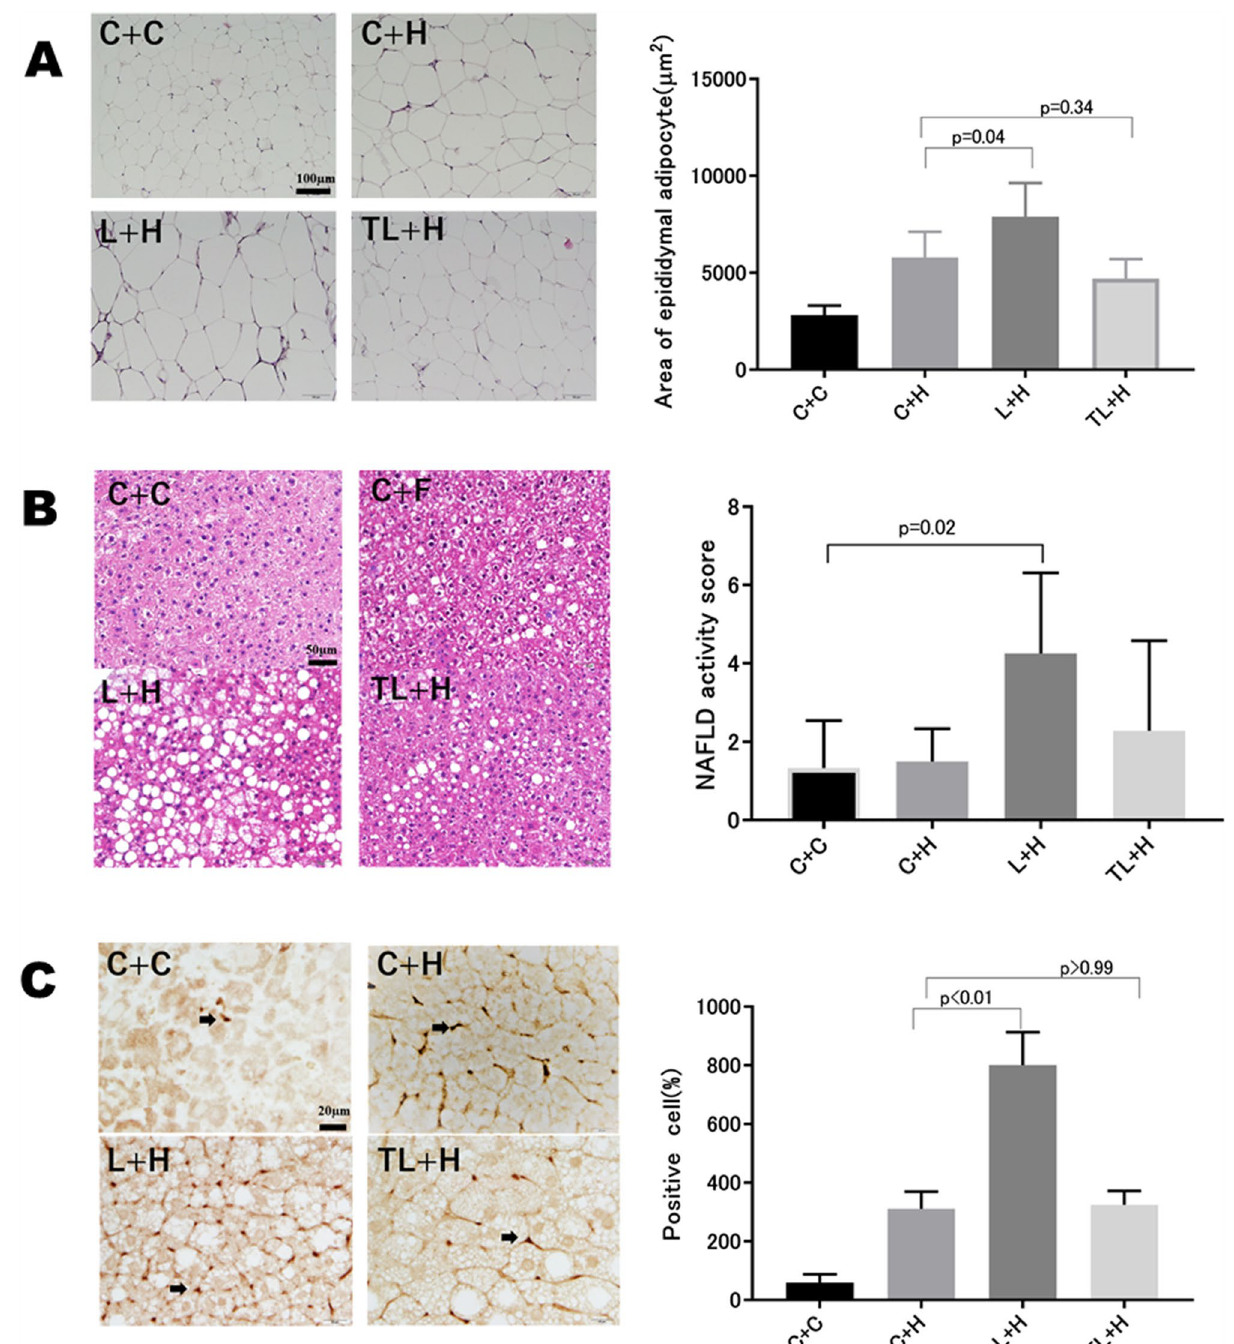
Figure 3. Histological examinations of tissues from the different treatment groups. ( A ) A liver at 20 weeks postnatally (HE stain, × 200 magnification). ( B ) Epididymal fatty cell area (HE stain, × 200 magnification). ( C ) F4/80 immunohistochemistry (arrow: positive cells, × 400 magnification). Morphologic changes in the liver and adipose tissue due to tadalafil and L-NAME administration. C + C indicates treatment naïve mice to whom no maternal intervention or HFD was given. Data are presented as the mean ± standard deviation, n = 4–7/ group. ***p < 0.001, **p < 0.01, *p < 0.05, based on a one way-analysis of variance with a post hoc Tukey test for multiple comparisons. C + C control + control diet, C + H control + HFD, HE hematoxylin and eosin, HFD high-fat diet, L + H L-NG-nitroarginine methyl ester + high-fat diet, L-NAME L-NG-nitroarginine methyl ester, NAFLD non-alcoholic fatty liver disease, TL + H L-NAME + tadalafil + HFD, TL + H L-NG-nitroarginine methyl ester + tadalafil + high-fat